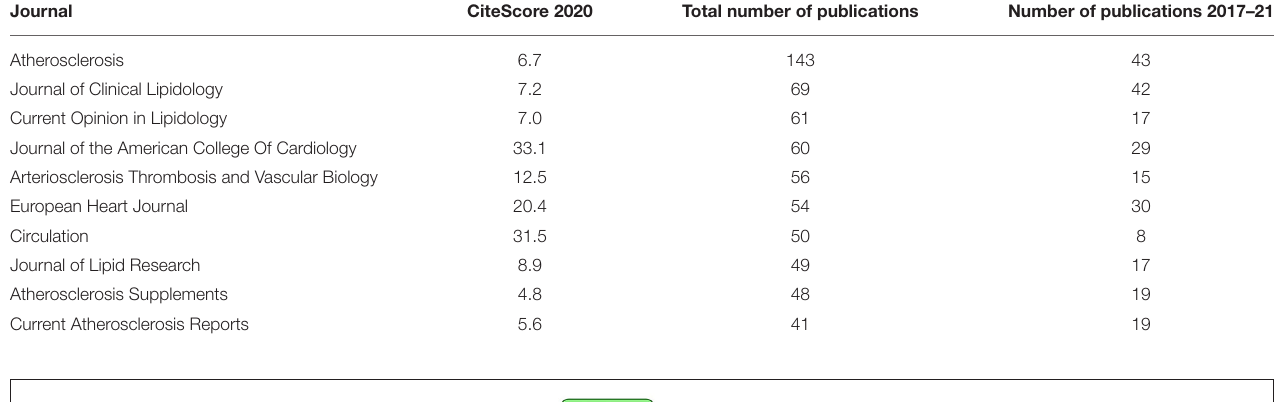
TABLE 3 | Ten most prolific journals in lipoprotein(a) research.